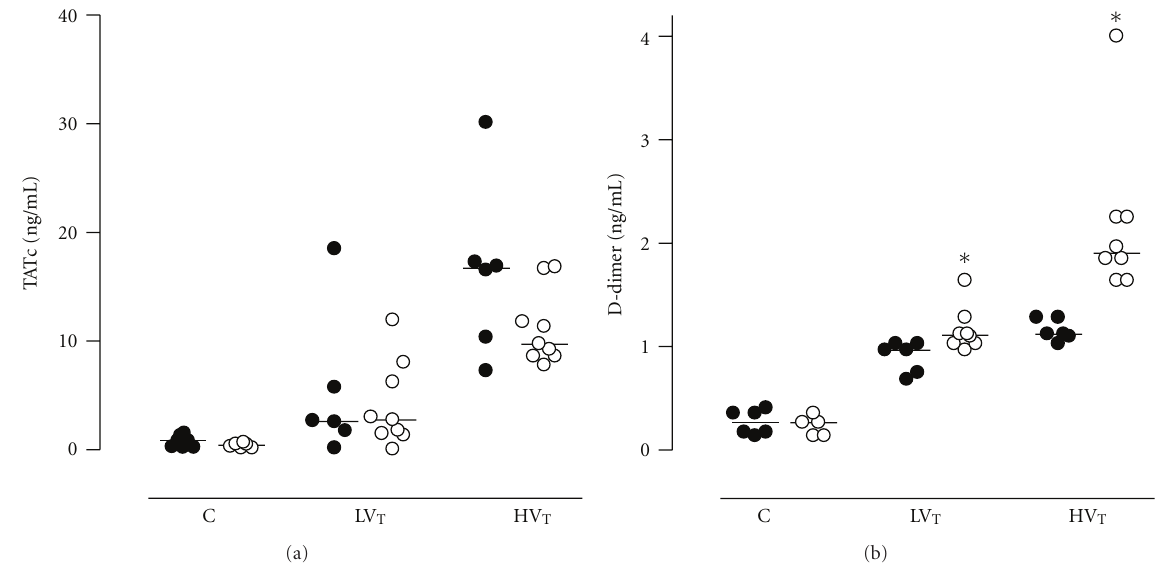
Figure 2: Thrombin-antithrombin complexes (TATcs) levels in bronchoalveolar lavage fluid and levels of fibrin degradation products in lung homogenate in anesthetized nonventilated control (C) mice, mice ventilated with LV T or HV T . Mice were either PAI-1 deficient (PAI-1 − / − , open symbols) or wild type (Wt, closed symbols). Data are represented as individual data with a median. ∗ , indicates statistical significant di ff erence compared to